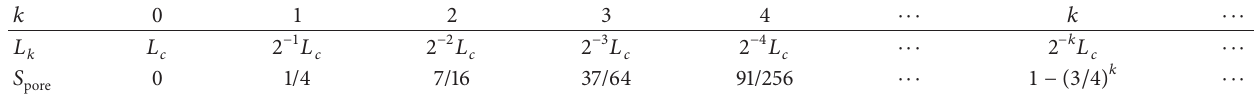
Table 2: The area distribution of Sierpinski